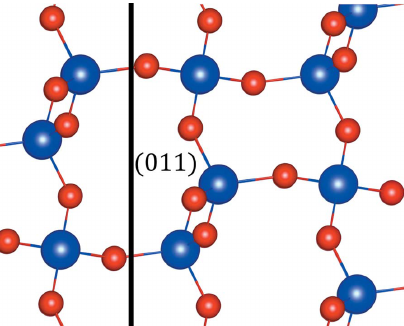
Figure 14 The structure of quartz viewed along the (011) plane. The [011]* reciprocal lattice direction is horizontal.